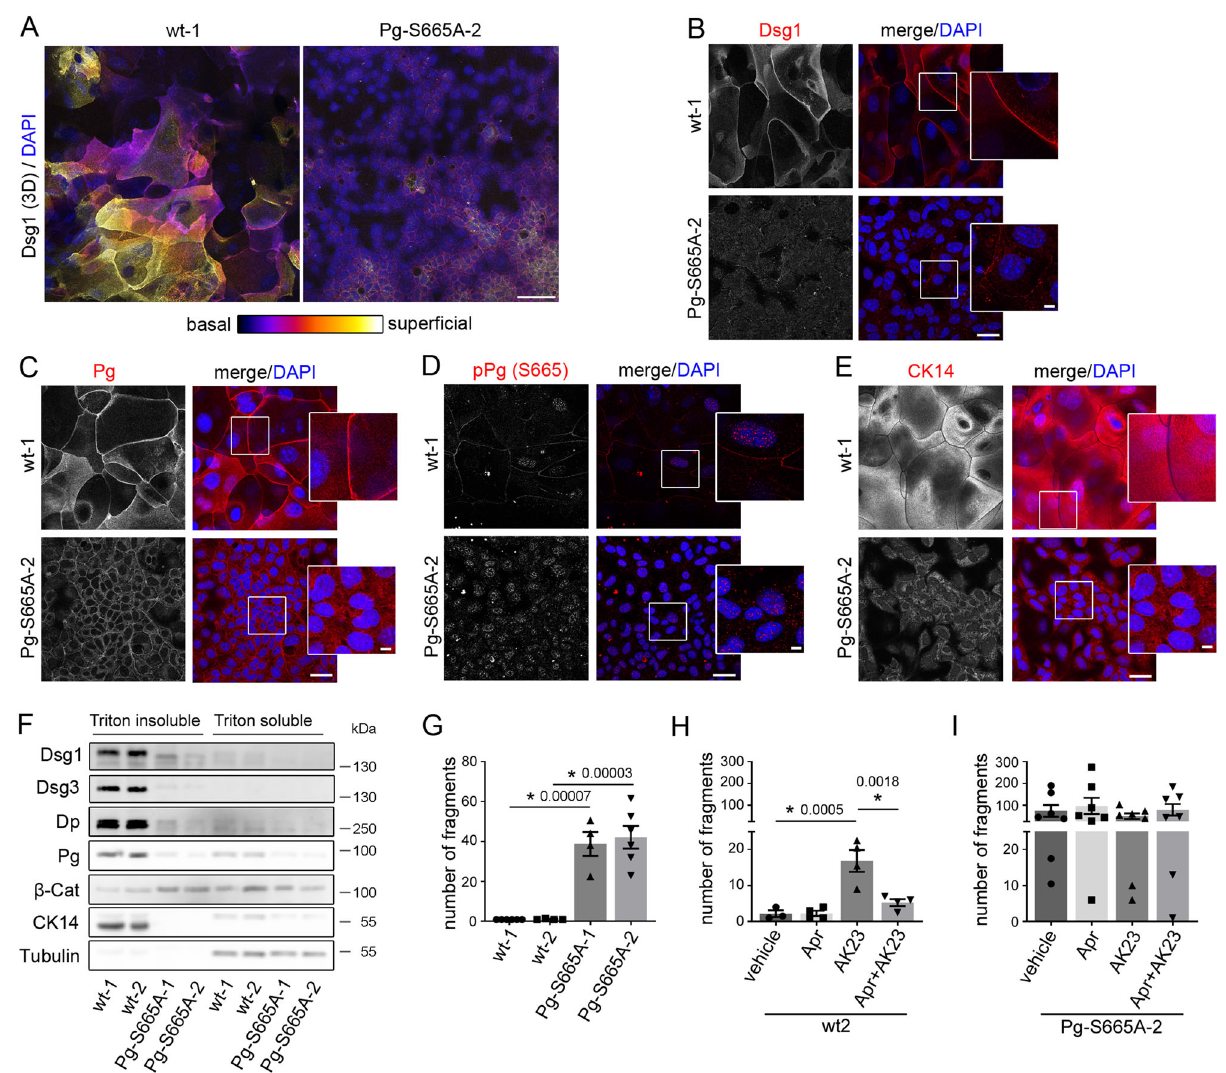
Fig.6|Keratinocytesphospho-de fi cientatPgS665(Pg-S665A)revealimpaired intercellular adhesion accompanied with drastic changes in desmosomal proteins and keratin fi lament cytoskeleton. A Color-encoded Z-stack of wt and Pg-S665A keratinocytes revealed multiple layers in wt and only 1-2 layers in Pg- S665A keratinocytes. Representative of n =3. Scale bar=50 µ m. A , B Dsg1 was expressed primarilyin the super fi cialepidermallayersina linear fashion along cell borders.Incontrast,Dsg1wasdrasticallyreducedandrestrictedtothebasallayerin Pg-S665Akeratinocytes. C PgwasreducedandappearedlesslinearizedinPg-S665A keratinocytes compared to wt. D pPg-S665 was absent in Pg-S665A keratinocytes con fi rming phospho-de fi ciency at this site whereas it appeared dotted along cell borders and in the nucleiin wt keratinocytes. E The keratin cytoskeleton showeda dense network spanning the whole cell in wt keratinocytes whereas it was rare fi ed and drastically altered in Pg-S665A keratinocytes. B – E Scale bar=25 µ m. White rectangles depict areas for zoom in. Scale bar (zoom)=5 µ m. Representatives of n =4 ( B ), n =3 ( C – E ). F Triton-based separation revealed a drastic impairment of Dsg1 and Dsg3 expression in the Triton insoluble, desmosome bearing fraction in